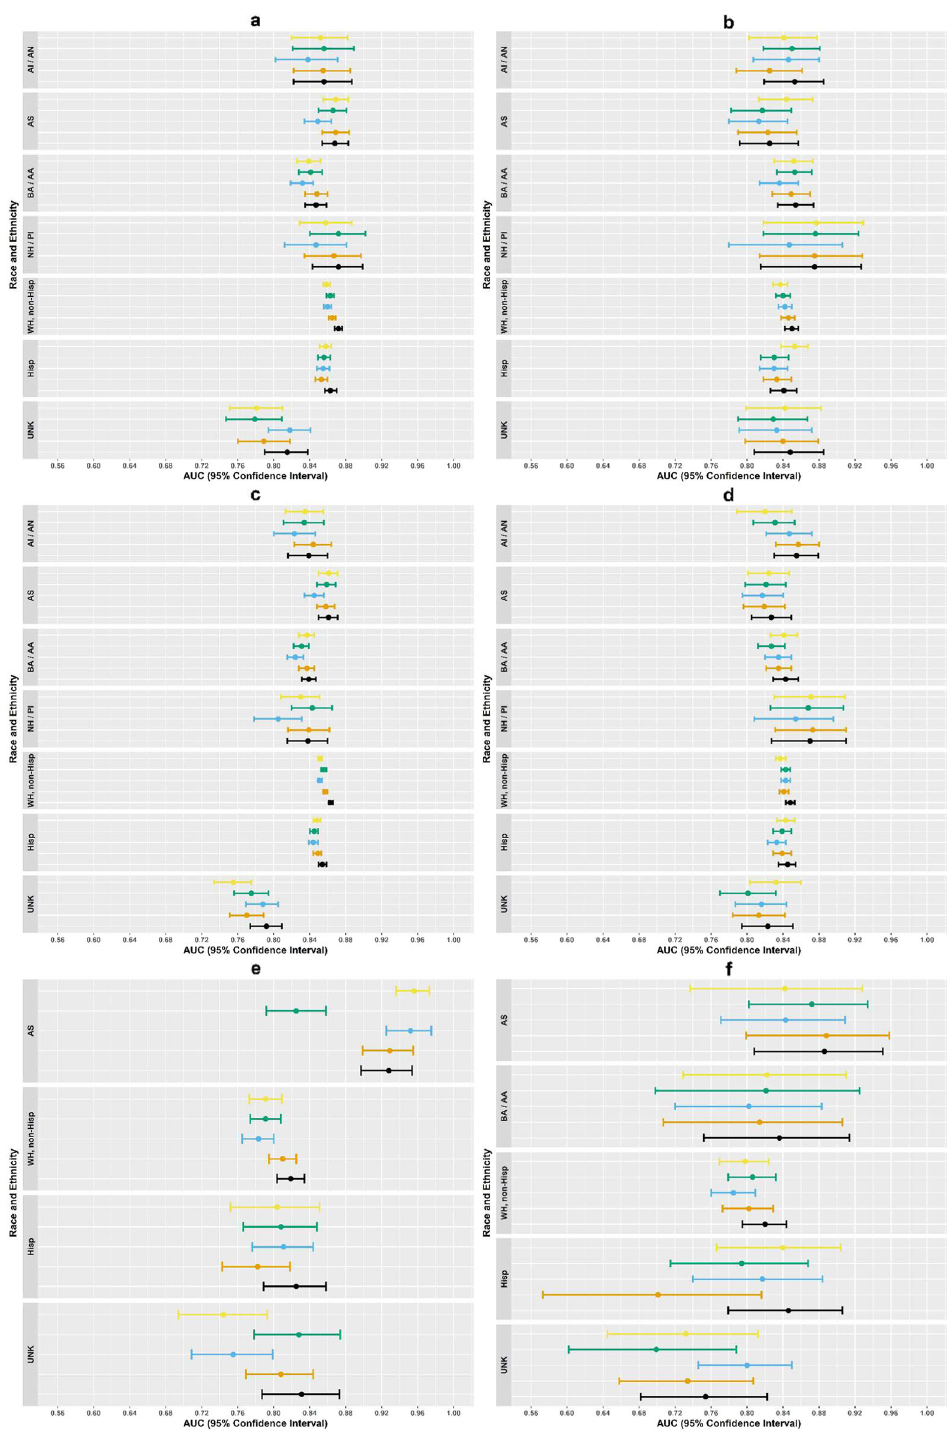
Fig. 3 Variation in area under the receiver operating curve (AUC) across racial and ethnic groups for all suicide risk prediction models. Each fi gure panel represents variation in AUC across racial and ethnic groups for different samples, outcomes, and follow-up periods. ( a ): 30-day suicide attempt prediction models, mental health specialty visits; ( b ): 30-day suicide attempt prediction models, general medical visits; ( c ): 90-day suicide attempt prediction models, mental health specialty visits; ( d ): 90-day suicide attempt prediction models, general medical visits; ( e ): 90-day suicide prediction models, mental health specialty visits; ( f ): 90-day suicide prediction models, general medical visits. AI/ AN = American Indian/Alaska Native; AS = Asian; BA/AA = Black/African American; NH/PI = Native Hawaiian/Paci fi c Islander; WH, non-Hisp = white, non-Hispanic; Hisp = Hispanic; UNK = unknown. Original parsimonious (yellow); Logistic regression with lasso variable selection (green); Random forest (blue); Arti fi cial neural network (orange); Ensemble model using logistic regression, random forest, and arti fi cial neural network models with detailed temporal predictors (black). Dots represent AUC in left out validation sample and lines represent upper and lower bounds on 95% con fi dence intervals based on 10,000 bootstrap samples. Note, due to low number of suicide deaths observed in individuals selecting AI/AN, BA/AA, or NH/PI, con fi dence intervals for 90-day suicide death were not